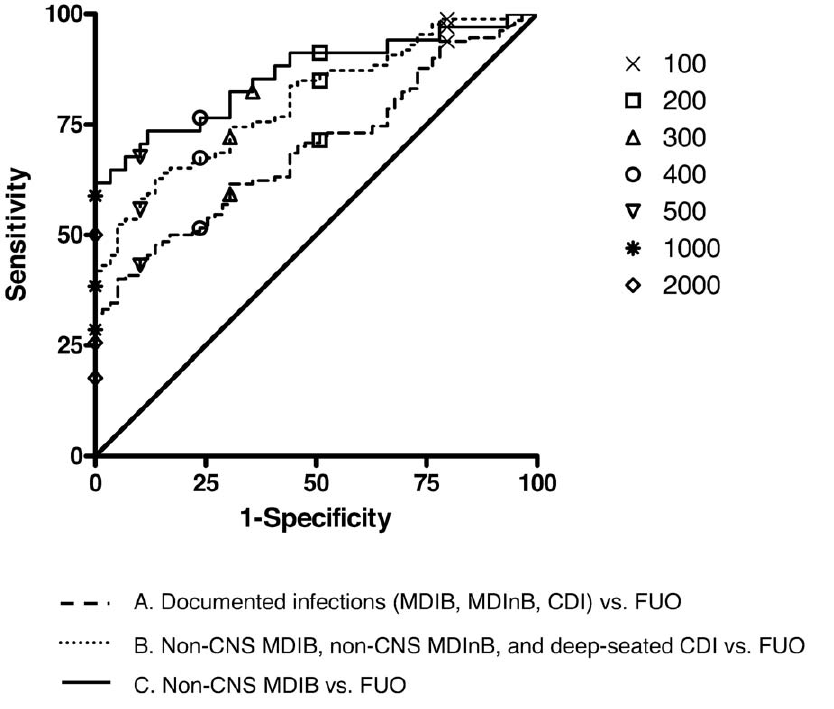
Figure 3. Receiver operating characteristic curve of PCT on day 2 after onset of fever for diagnosis of A. documented infections (MDIB, MDInB, CDI) vs. FUO (AUC=0.695); B. non-CNS MDIB, non-CNS MDInB, and deep-seated CDI vs. FUO (AUC=0.803); and C. non-CNS MDIB vs. FUO (AUC=0.860). MDIB=microbiologically documented infections with bacteremia, MDInB=microbiologically documented infections without bacteremia, CDI=clinically documented infections, FUO=fever of unknown origin, CNS=coagulase-negative staphylococci, AUC=area under the receiver operating characteristic curves.